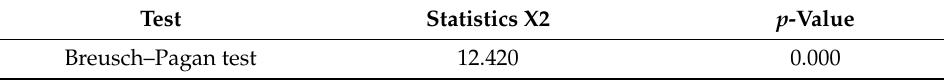
Table A12. The results of the fourth model variance heterogeneity test.